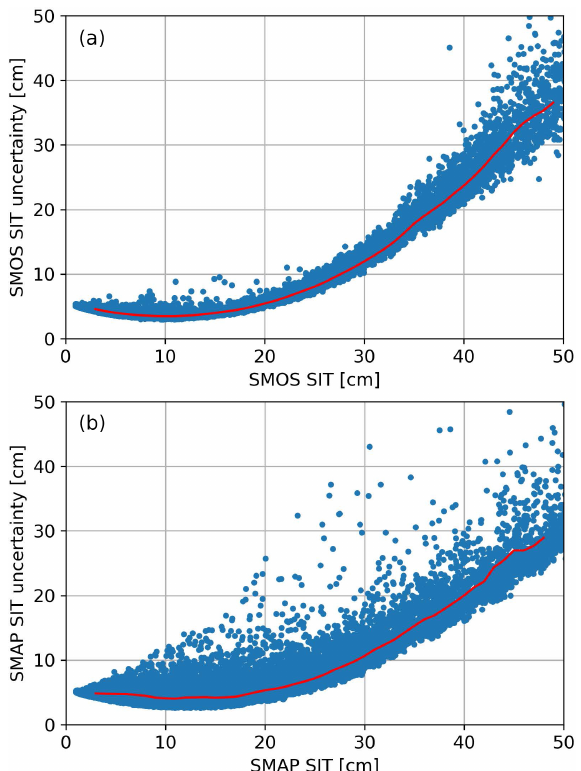
Figure 10. Scatter of SMOS (a) and SMAP (b) retrievals at the 40 ◦ incidence angle for 24 October 2015 in the Arctic and their respective uncertainties. The red line shows the rolling average of the